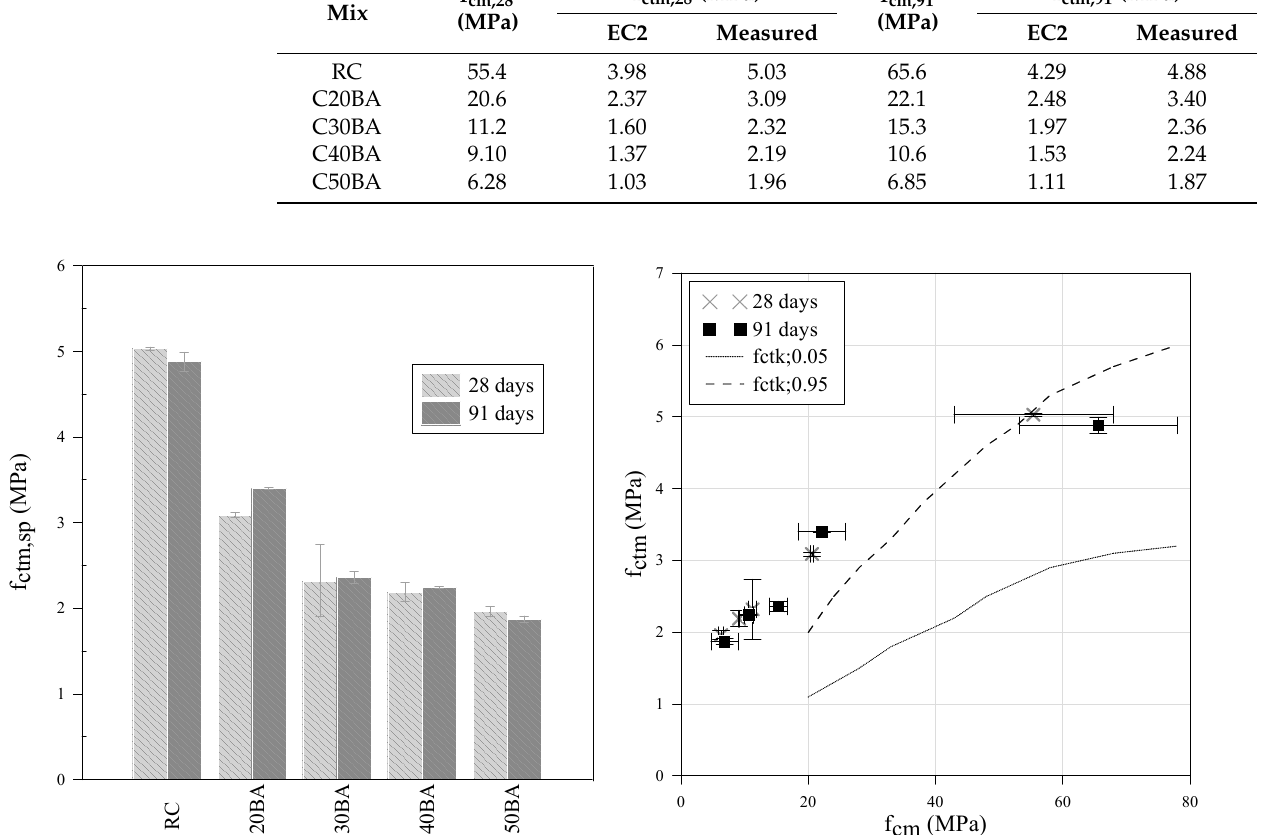
Figure 4. Splitting tensile strength (f ctm,sp ) vs. replacement level ( left ); relationship between tensile strength (f ctm ) and compressive strength in cylindrical specimens (f cm ) at 28 and 91 days ( right ).